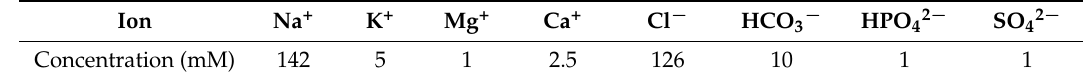
Table 2. Ionic composition of SBF10